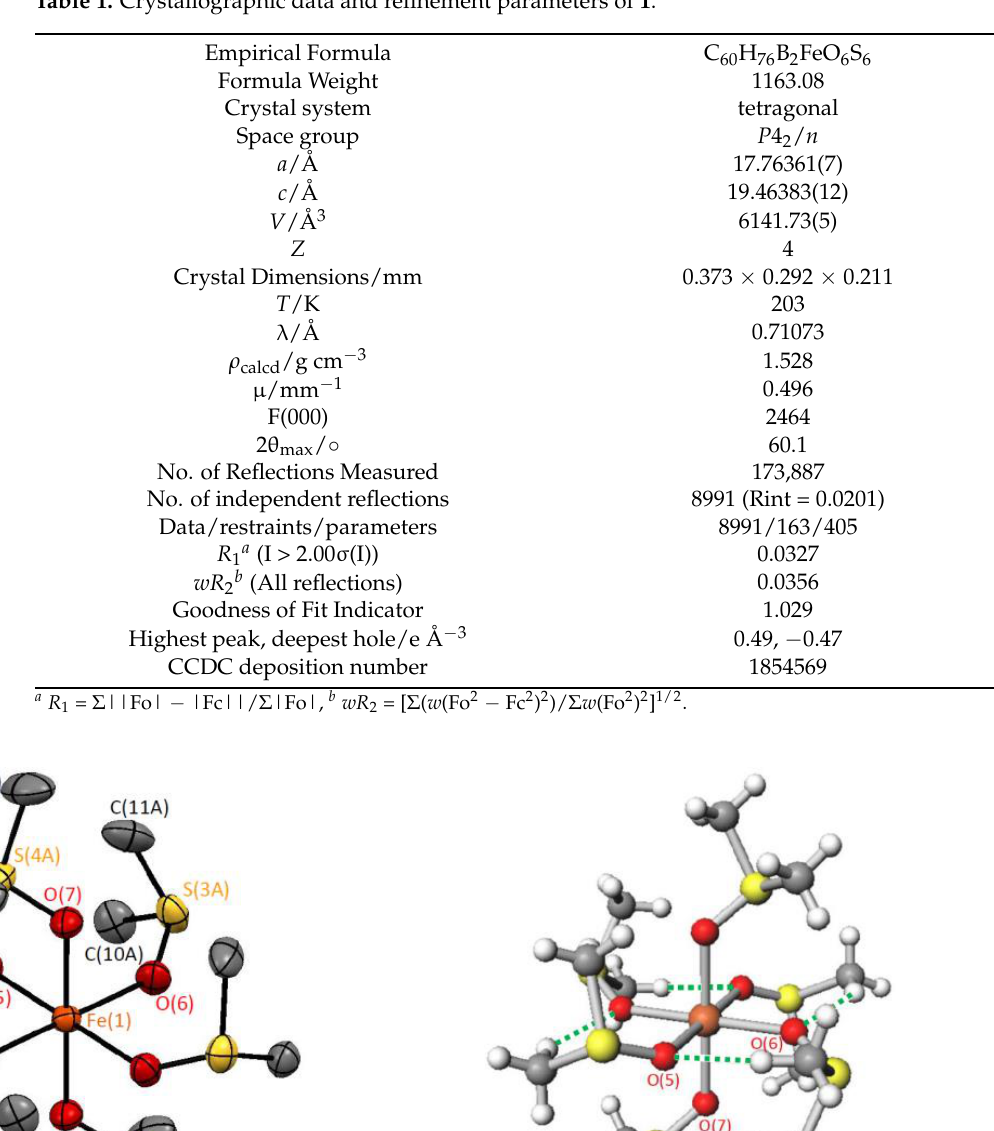
Table 1. Crystallographic data and refinement parameters of 1 .